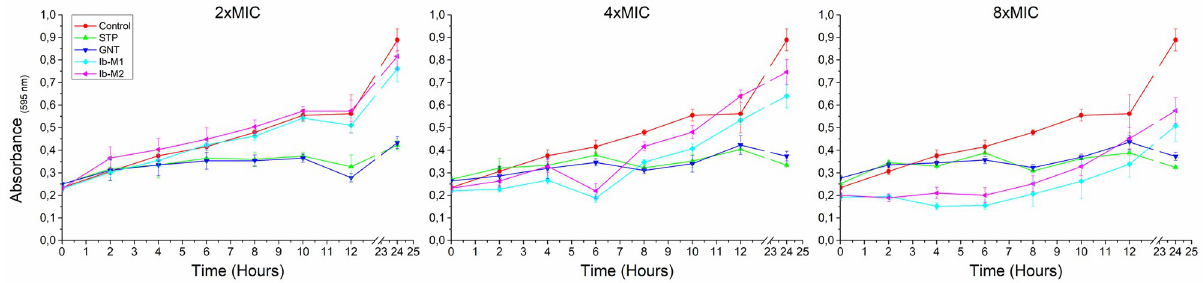
Fig 3. Growth kinetics of E . coli O157:H7 with Ib-M peptides in log phase. Each concentration was evaluated in quadruplicate. Results are expressed in terms of the arithmetic average ± standard deviation. Data representative of two independent experiments with similar results is shown. STP: Streptomycin, GNT: Gentamicin.